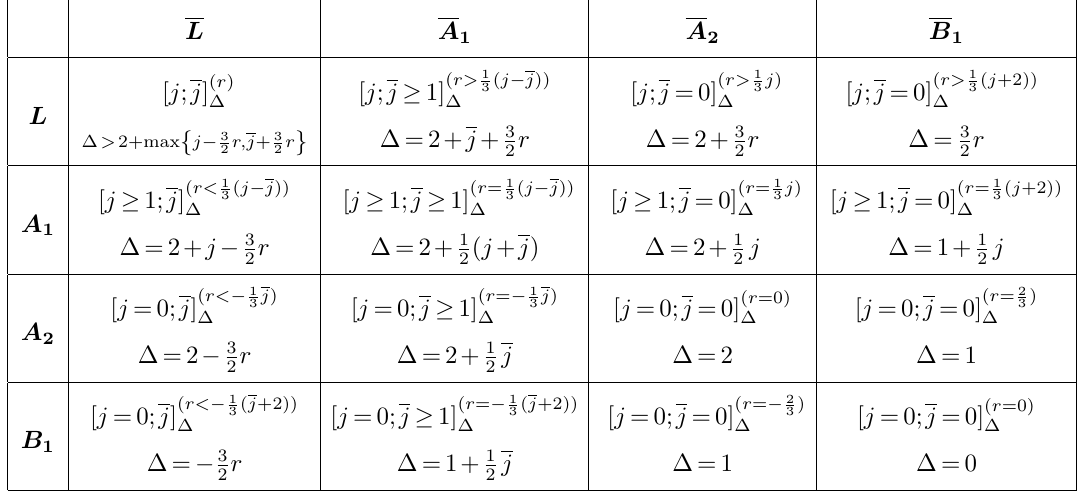
Table 12 . Consistent two-sided multiplets in four-dimensional N = 1